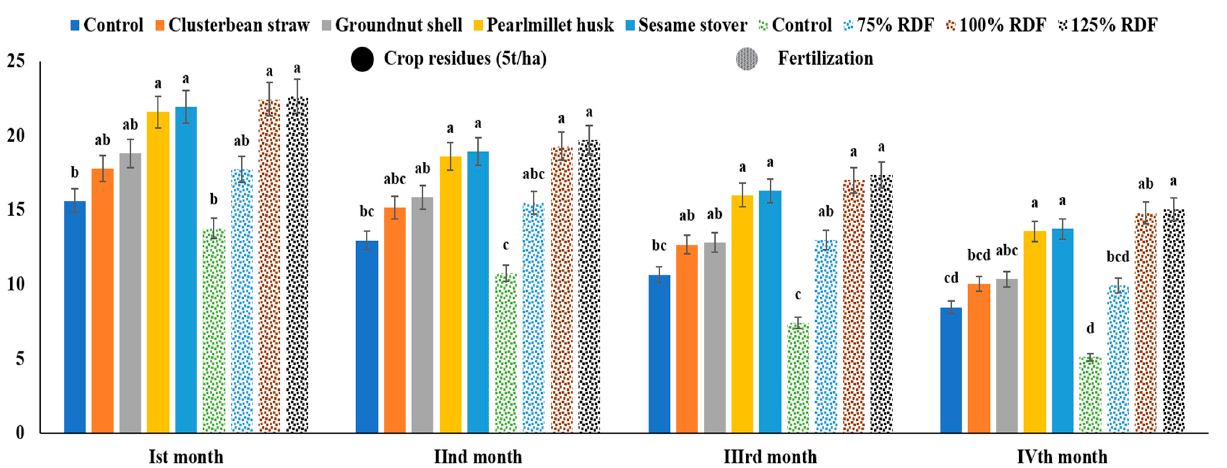
Figure 2. Effect of crop residues and fertilization on microbial biomass nitrogen (µg g − 1 ) at first, second, third, and fourth month after sowing. In this figure, the values followed by different lower- case letters indicate no significant difference ( p > 0.05) by Duncan’s multiple range test (DMRT).